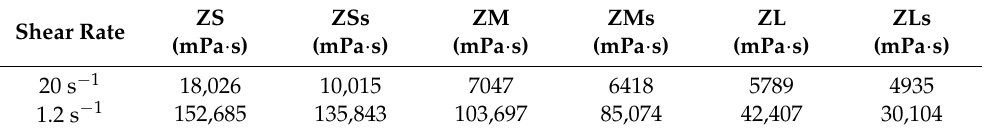
Table 4. Change in viscosity with shear